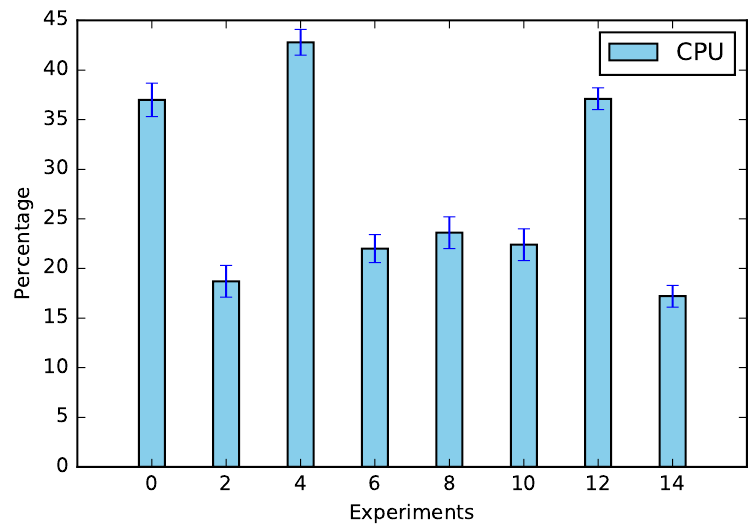
Figure 8. CPU usage with and without the appliance